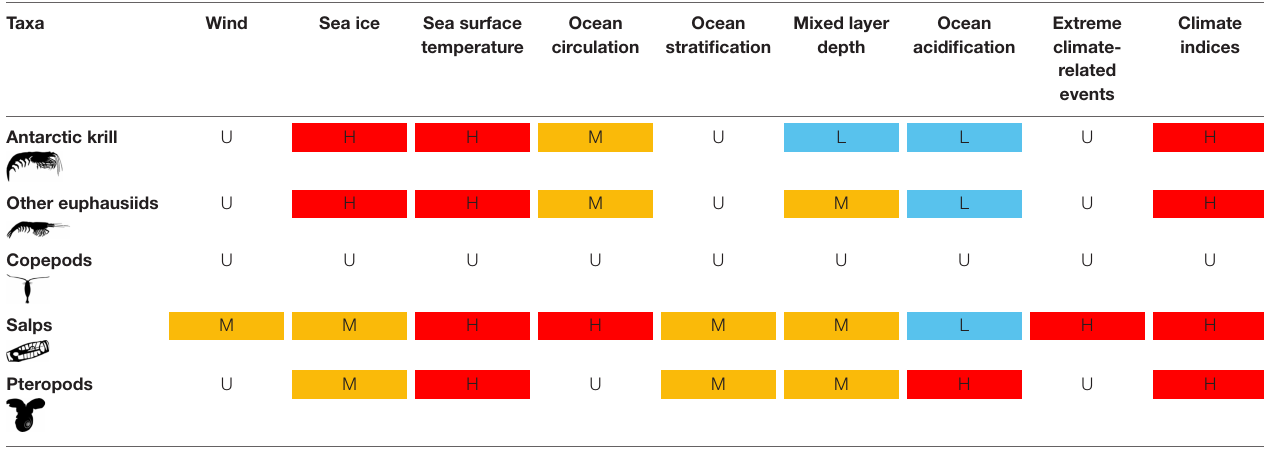
TABLE 1 | Assessment* of the potential impacts of key physical and chemical drivers of change on the distribution and abundance of key Southern Ocean zooplankton taxa (based on information provided in Sections “Euphausiids (Family Euphausiidae), Copepods (Subclass Copepoda), Salps (Order Salpida), Pteropods (Order Pteropoda), and Past Changes in Zooplankton: A Modelled Example Using Continuous Plankton Recorder Data”, including references cited therein). See Supplementary Table 3 for a more detailed assessment of the potential future changes in these taxa (in response to some of these drivers) and their potential capacity for